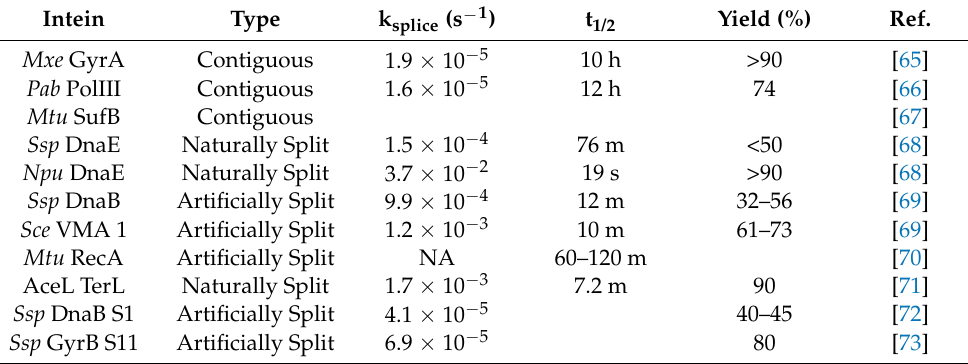
Table 1. Inteins of various characteristics for intein-mediated protein engineering. Intein